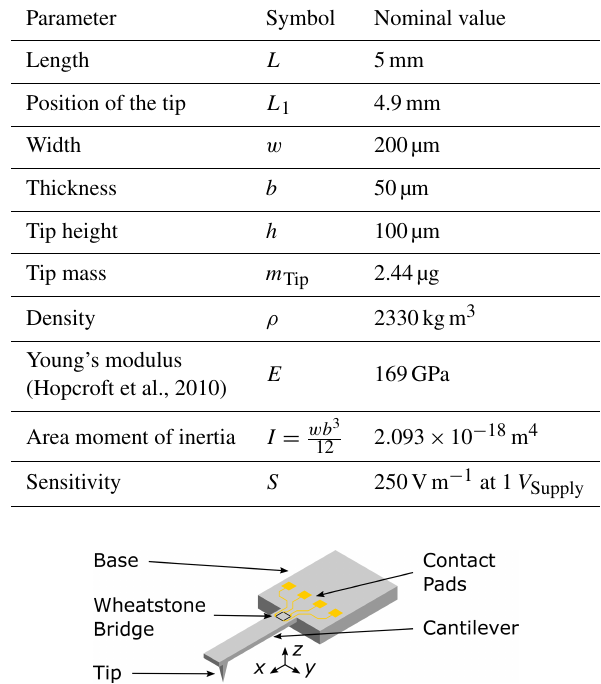
Table 1. Geometrical and mechanical parameters of the microprobe (CiS Forschungsinstitut für Mikrosensorik GmbH, 2018).